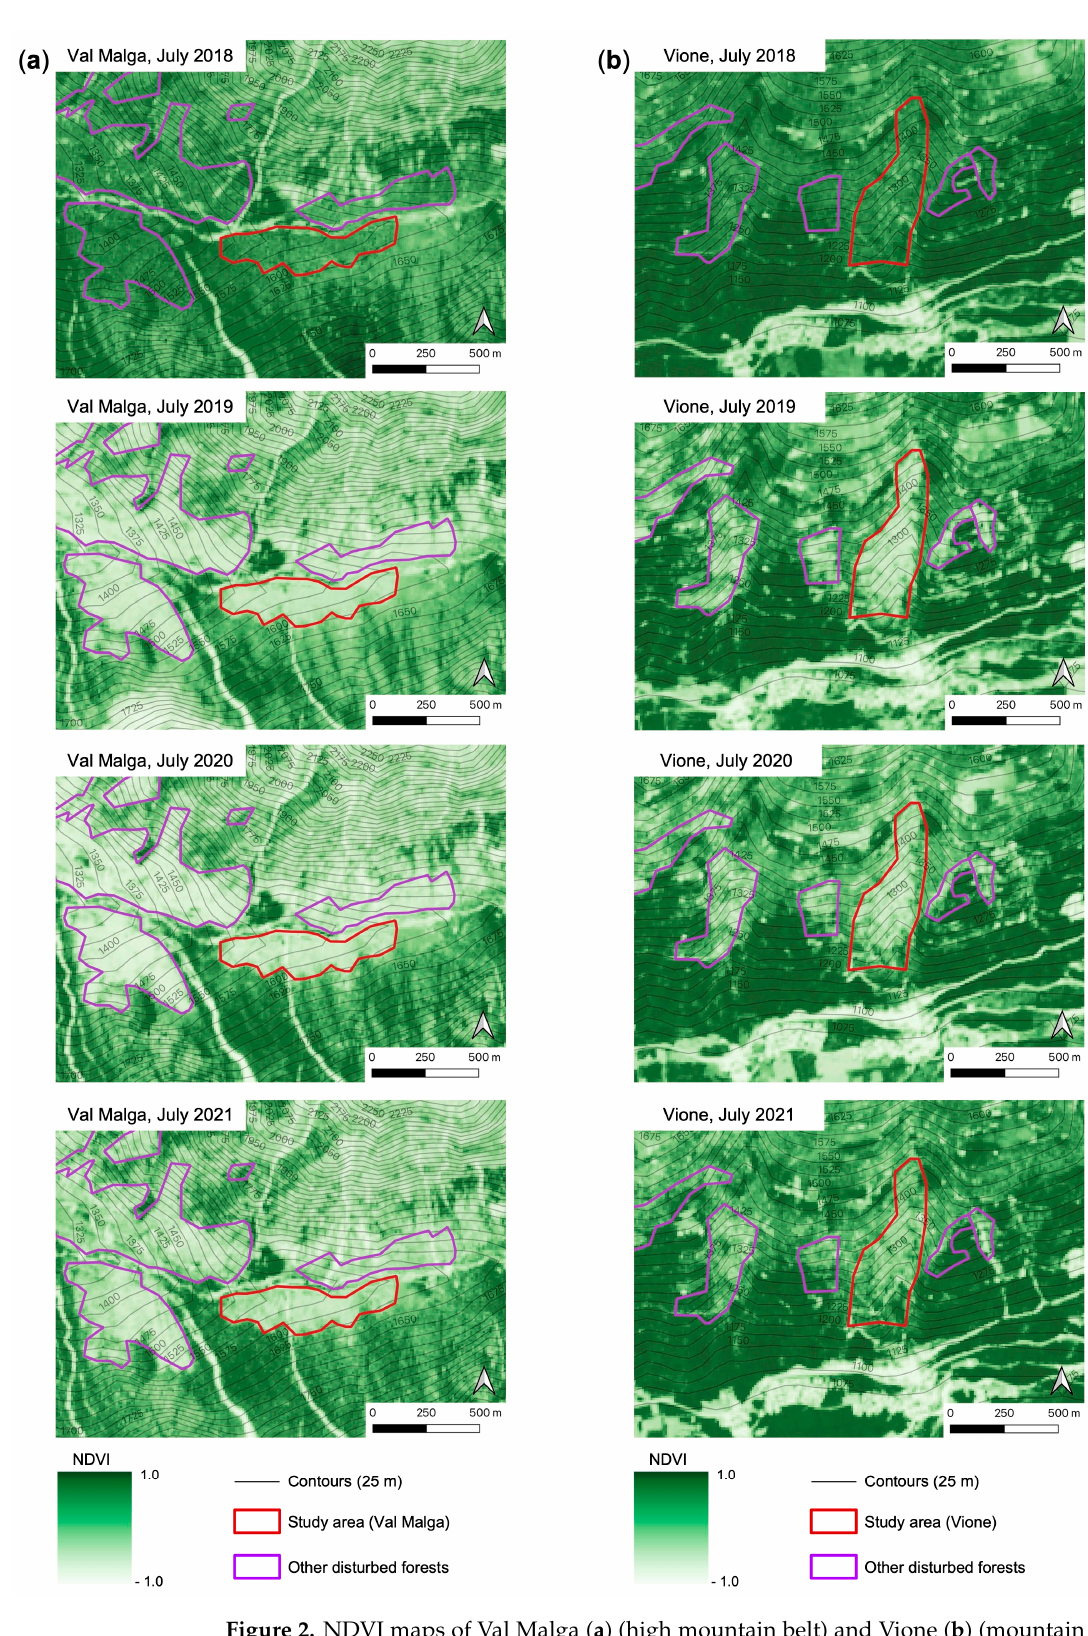
Figure 2. NDVI maps of Val Malga ( a ) (high mountain belt) and Vione ( b ) (mountain belt) in July 2018 (before Vaia storm), 2019, 2020, and 2021. The borders of the two study areas are in red while the purple lines delimit other forests disturbed by the Vaia storm (data provided by Comunit à Montana di Valle